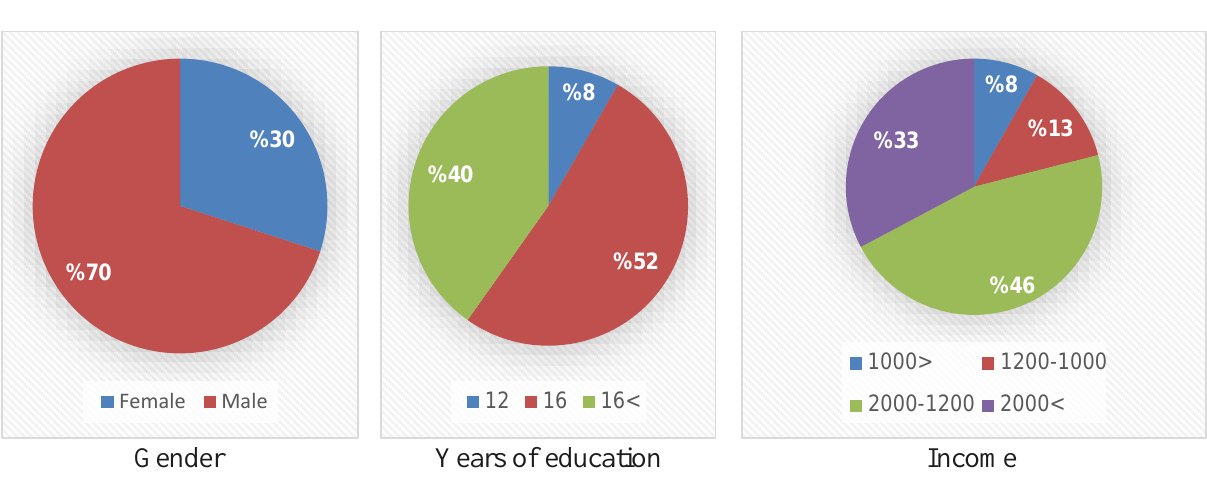
Fig. 1. Personal characteristics of the